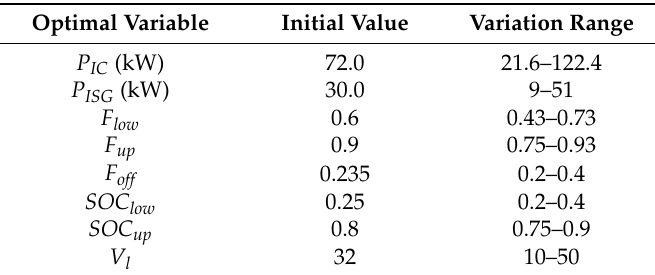
Table 6. Variation of each